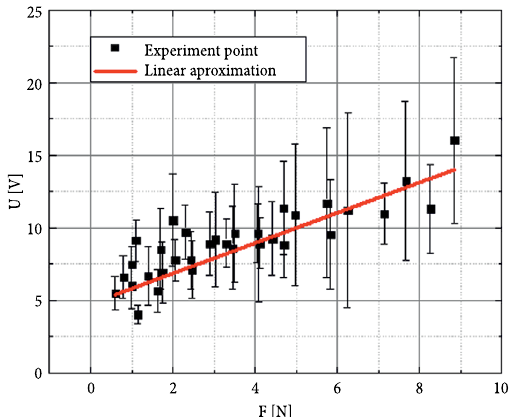
Fig. 4. Experimental characteristics of piezoelectric sensors U = f ( F